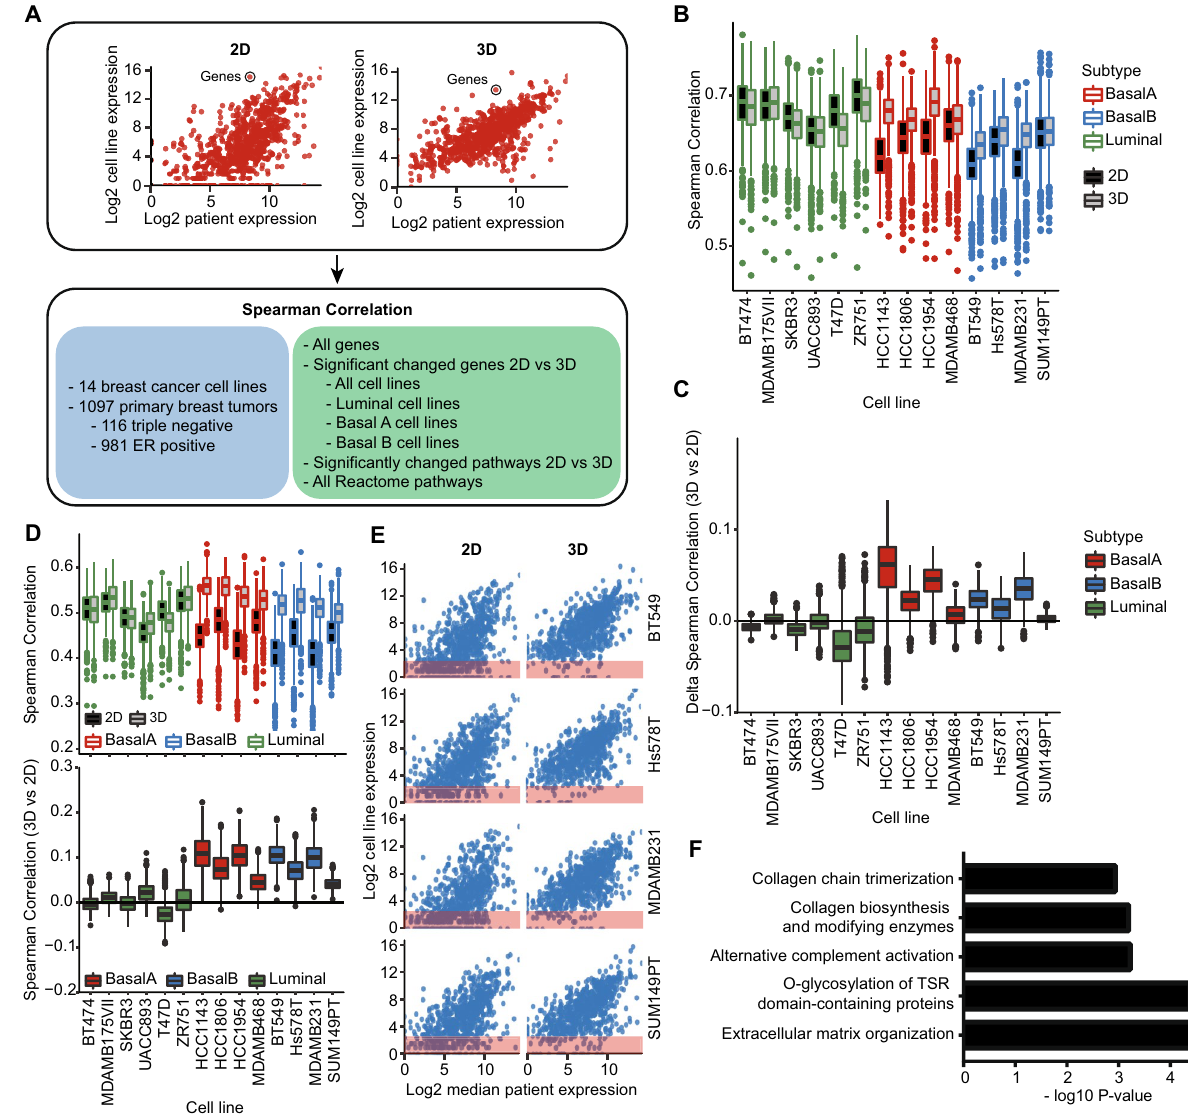
Figure 5. Comparison the transcriptomes of 2D and 3D cell culture models with patient derived primary tumor transcriptomes. ( A ) Analysis overview. Spearman correlations were calculated between the different transcriptomes using log2 normalized gene expression levels taking into consideration cell line subtypes, tumor subtypes and different gene sets. ( B ) Spearman correlation of log2 normalized RNA expression levels between cell lines and patient primary breast tumors (n = 1097). Boxes represent median and interquartile range of all tumor correlations. All genes and all tumors (irrespective of subtype) were included in the correlation calculations. ( C ) Difference in spearman correlation comparing 2D and 3D cell line cultures matched by patient tumor. All genes and all tumors were included in the correlation calculations. Boxes represent median and interquartile range of the difference in spearman correlation for all tumors. ( D ) Spearman correlation of log2 normalized RNA expression levels of basal B DEGs (paired analysis, p < 0.01) between cell lines and patient primary breast tumors (n = 1097). Boxes represent median and interquartile range of all tumor correlations. Only DEGs comparing 2D and 3D cultures for the basal B cell lines were included in the correlation calculations (top). Difference in spearman correlation comparing 2D and 3D cell line cultures matched by patient tumor. Only DEGs comparing 2D and 3D cultures for the basal B cell lines were included in the correlation calculations (bottom). Boxes represent median and interquartile range of the difference in spearman correlation for all tumors. ( E ) Log2 normalized RNA expression levels of basal B DEGs comparing 2D to 3D cultures (paired analysis, p < 0.01) in basal B cell lines and TCGA patient primary breast tumors. Red squares: genes with log2 RNA expression < 2. ( F ) Top 5 pathways of over-representation analysis of basal B DEGs comparing 2D to 3D cultures (paired analysis, p < 0.01) not or low expressed in 2D cultures and higher expressed in 3D